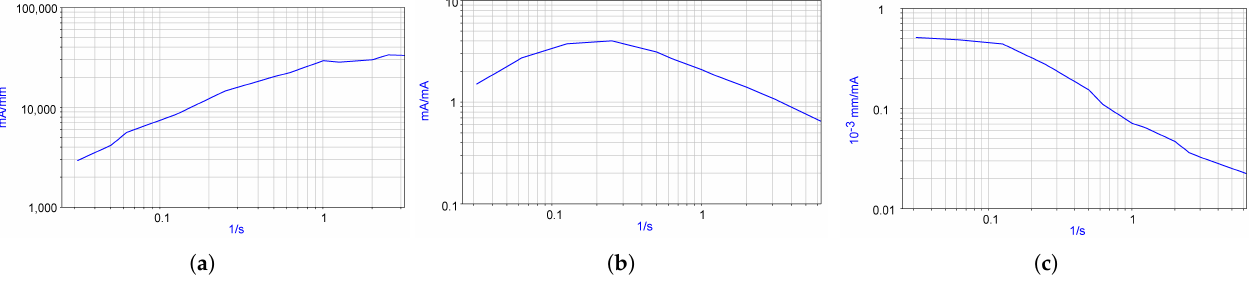
Figure 5. ( a ) Frequency response of MHD/MET system. The ratio of the signal current MET of the cell to the current in the MHD cell. ( b ) Ratio of cell signal current MET to mirror/platform bias. ( c ) Ratio of mirror/platform displacement to current in